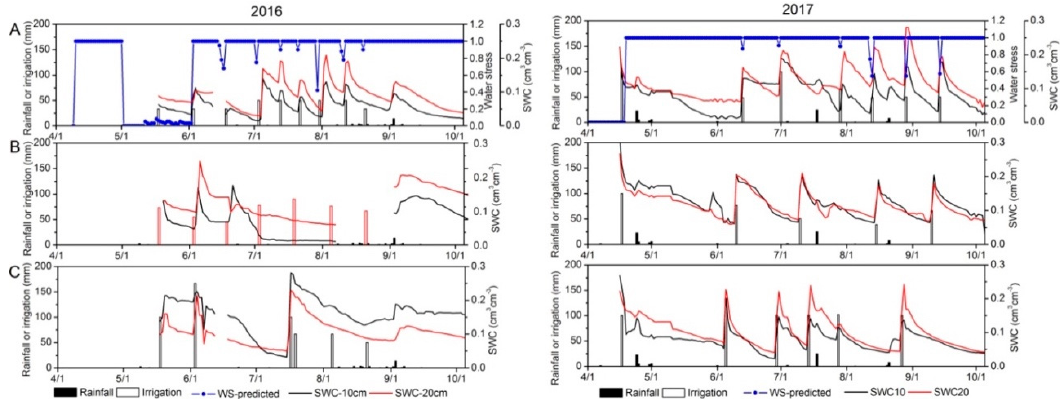
Figure 10. The water stress response to irrigation and rainfall in the D-FI treatment in 2016 and 2017 ( A ); soil water content response to irrigation and rainfall in the S-FI treatment in 2016 and 2017 ( B ); and soil water content response to irrigation and rainfall in the E-FI treatment in 2016 and 2017 ( C ). WS-predicted, predicted water stress; SWC, soil water content; SWC—0.10 m and SWC—0.20 m, soil water content monitored by sensor in 0.10 m and 0.20 m soil profile, respectively.